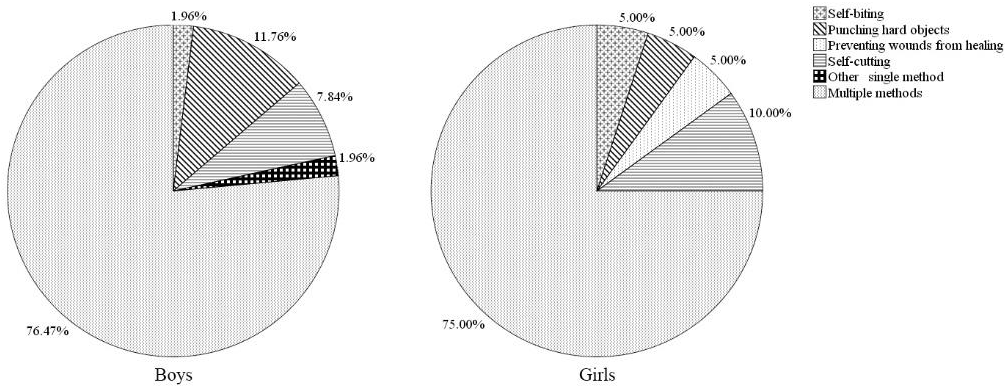
Figure 1. Methods of the DSH meeting study criteria during the previous year in children without disabilities, by gender.